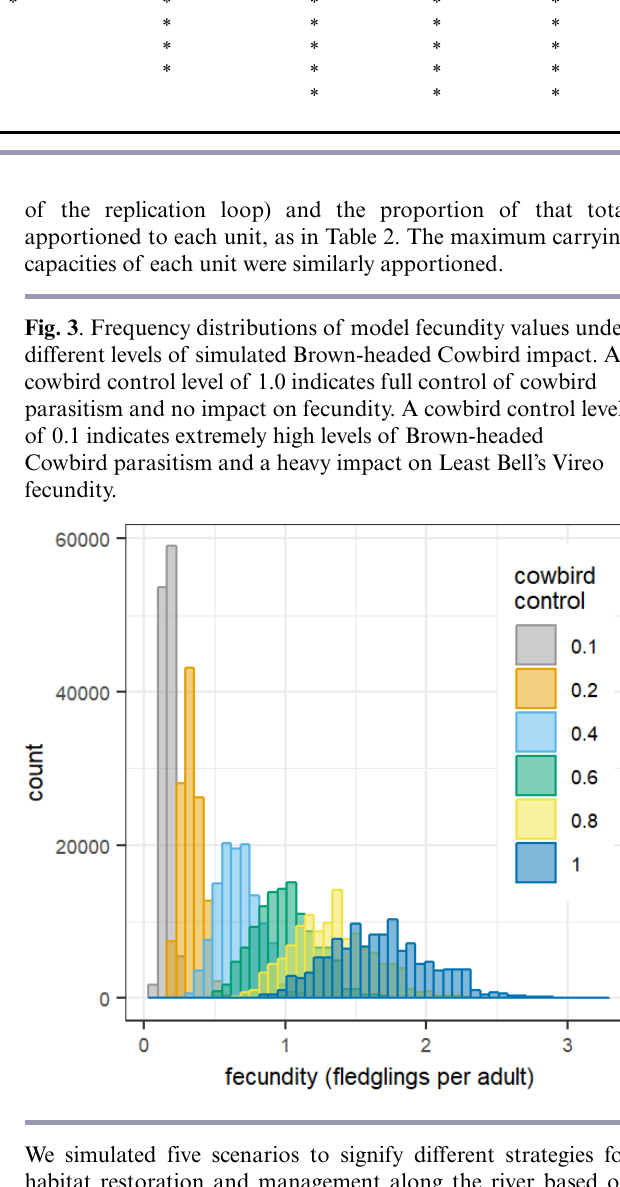
Table 2 . Parameters for habitat management scenarios. In addition to these five scenarios, we also ran a scenario with no habitat management for comparison. Management unit Proportion of initial carrying capacity